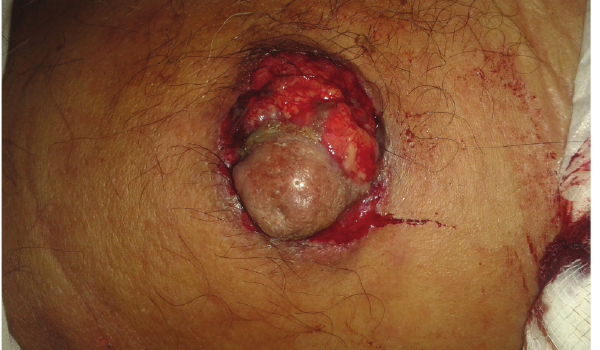
Figure 1: A fungating right breast mass